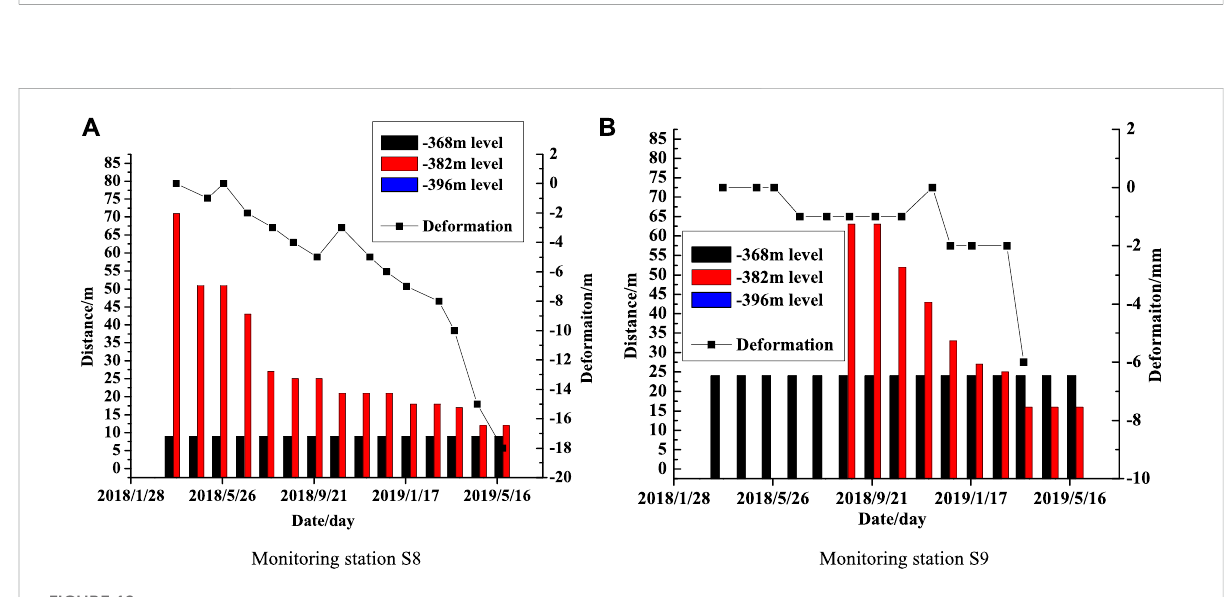
S8. (B) Monitoring station